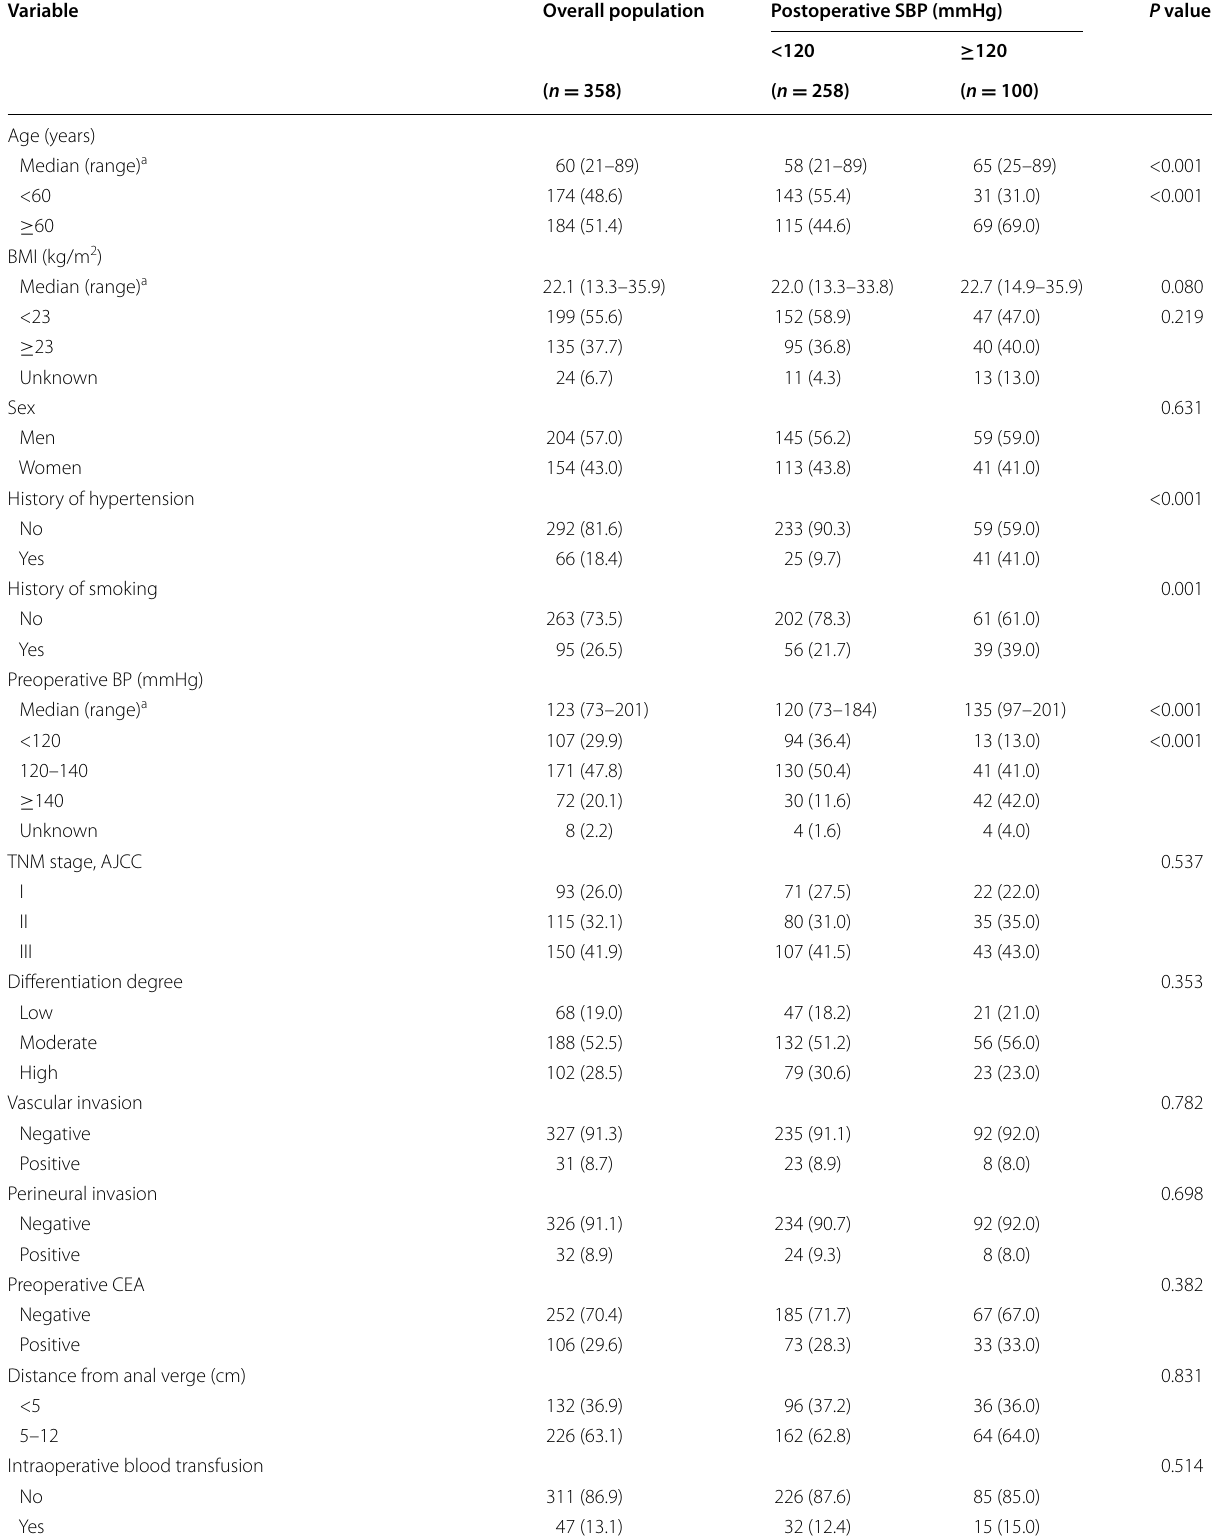
Table 1 Baseline characteristics and distribution of clinicopathologic variables for the 358 patients with rectal